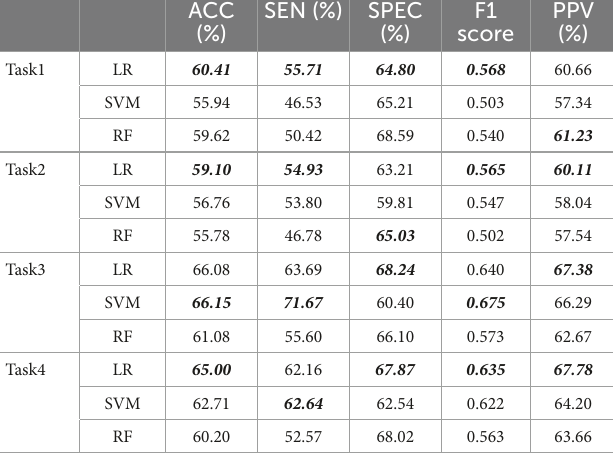
Boldanditalicvaluesrepresentthehighestvalueofevaluationcriterionsinthethreeclassifiers.